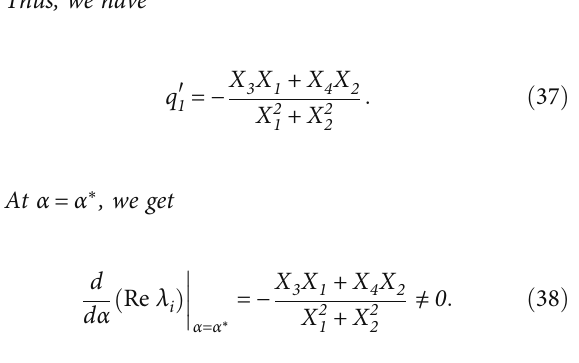
Figure 7: (a) Time series solution and (b) parametric plot of system (4) about the equilibrium point E except c 2 = 0 : 05, c 1 = 0 : 12, α = 1, and β = 0 : 2 .